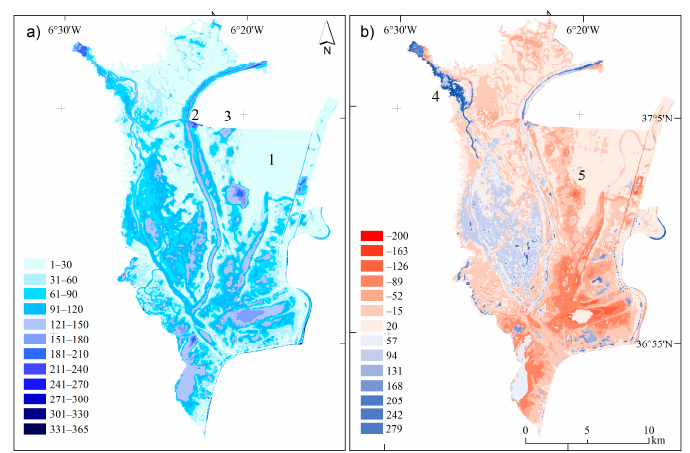
Figure 7. ( a ) Mean hydroperiod for Doñana marshes (1974–2014); ( b ) Hydroperiod anomaly calculated for the flooding cycle 2007–2008. Both are expressed in days per year. Numbers in both figures indicate interesting features (see text for more details).